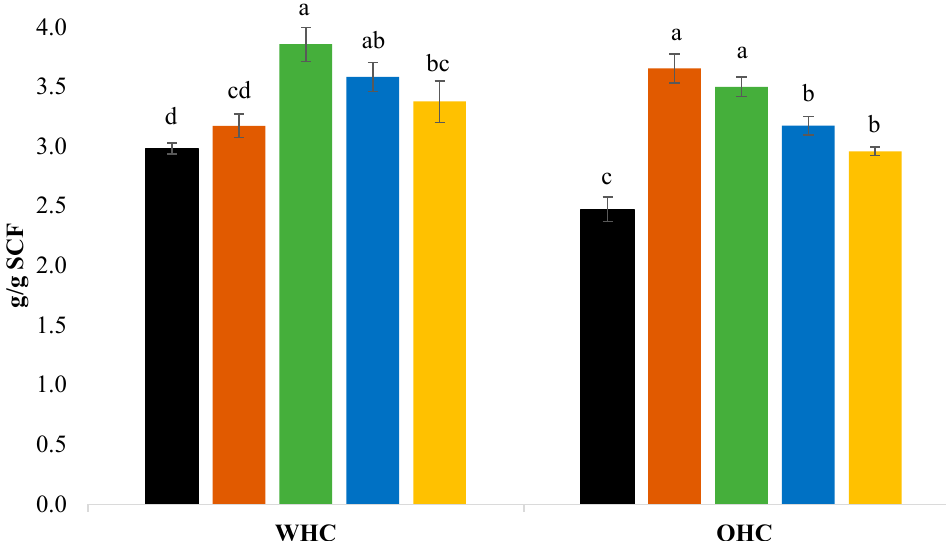
Figure 1. WHC and OHC of untreated and AHP SCF, different letters represent a significant difference within the same functional test ( p < 0.05), where n = 3.